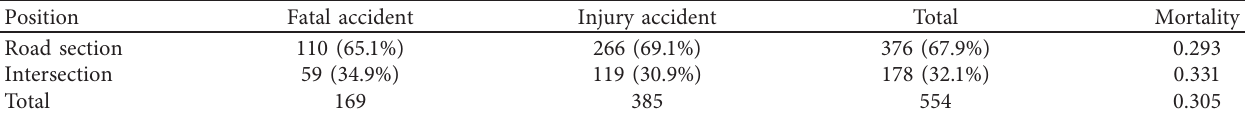
Figure 4: The variation tendency of crashes counted by the hours of the day (note that 0 in abscissa denotes 0:00–1:00, and others follow the rule). Table 5: Statistical information of crash position for injury severity.